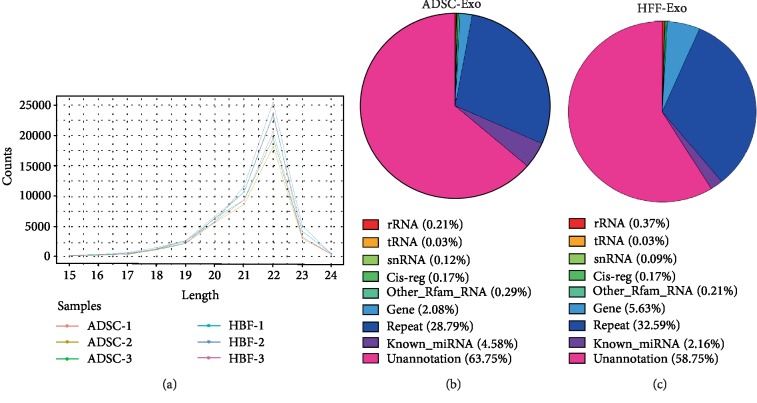
Next-generation sequencing of ADSCs and HFF exosomal miRNA. (a) Line graph of known miRNA lengths in each sample. (b and c) Pie chart of classification annotation of small RNA in ADSC-Exo exosomes and HFF-Exo exosomes.